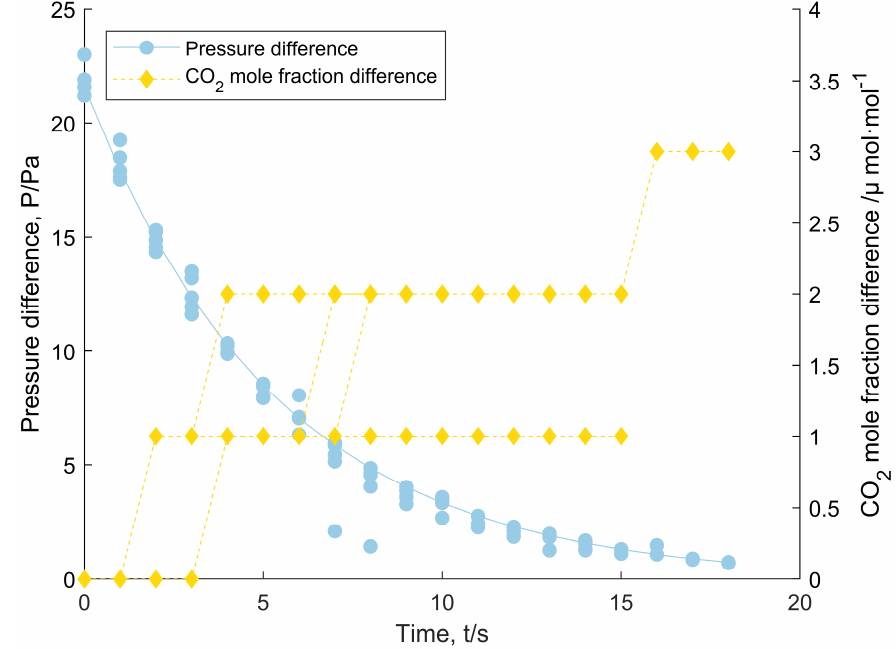
Figure 8. ( a ) Variation of CO 2 concentration values in O1–O3 layers of sandy loam, under stable conditions after aeration; ( b ) Stage II, sandy loam O1 layer, concentration variation condition and fitted curve after continuous pumping of 100 mL.